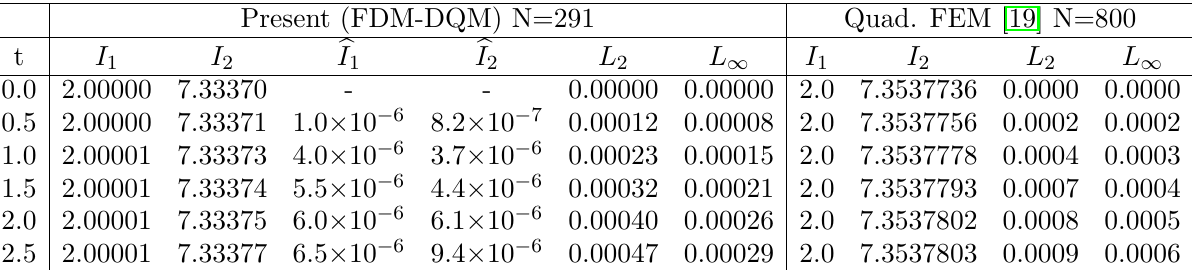
Figure 1. Simulation of single soliton ∆ t = 0 . 005 , N = 291. Table 2. Error norms, invariants and relative changes of invariants: ∆ t = 0 .